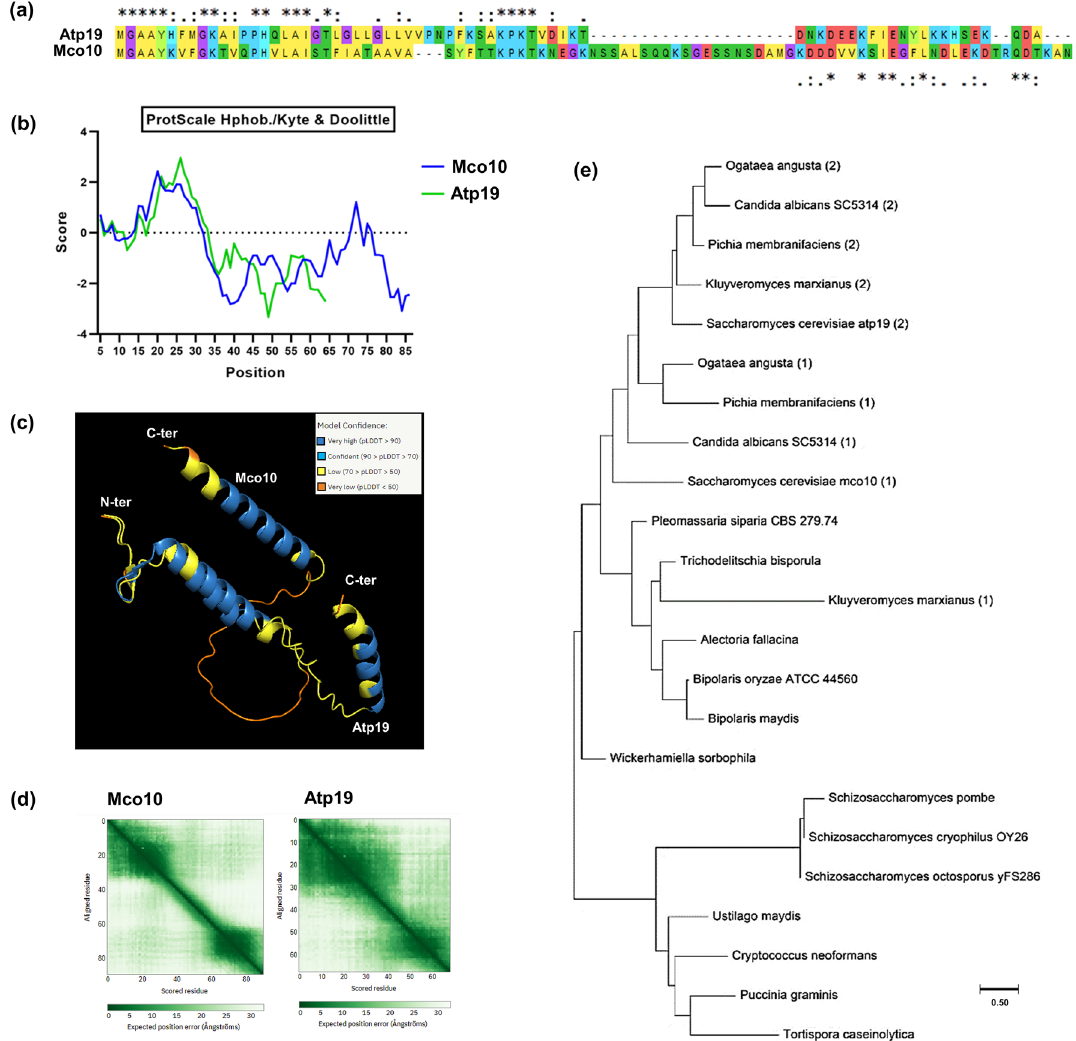
Figure 2. Mco10 and Atp19 phylogenetic and structural analysis. ( a ) Alignment of Mco10 and Atp19 sequences by Clustal Omega. ( b ) Hydropathy plots of Mco10 and Atp19 by Kate and Doolittle method using ProtScale on the ExPASy Server. ( c ) Structures of Mco10 and Atp19 as predicted in the model from AlphaFold2 database. The color code represents the model confidence as determined by the AI algorithm of AlphaFold2. The alignment was done using PyMol molecular visualization software. ( d ) AlphaFold’s expected position error PAE plot of Mco10 and Atp19. ( e ) Phylogenetic tree analysis of Mco10, Atp19 and related homologs in fungi. The tree was constructed using Maximum likelihood method with representative species from all subphylum of Ascomycota and representative examples of Basidiomycota . (1) represents Mco10 related homolog and (2) represents Atp19 related homolog when there were two distinct proteins present in the genome of the